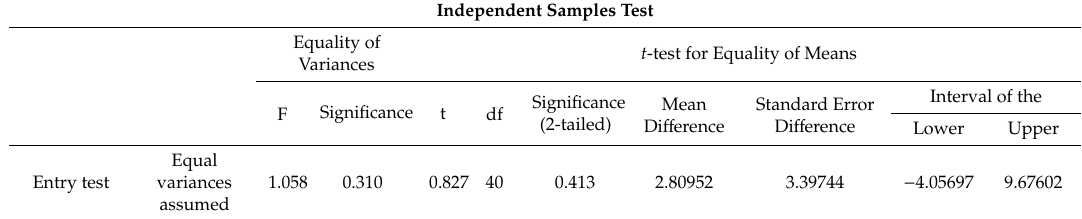
Table 5. Entry test—independent samples t -test results.